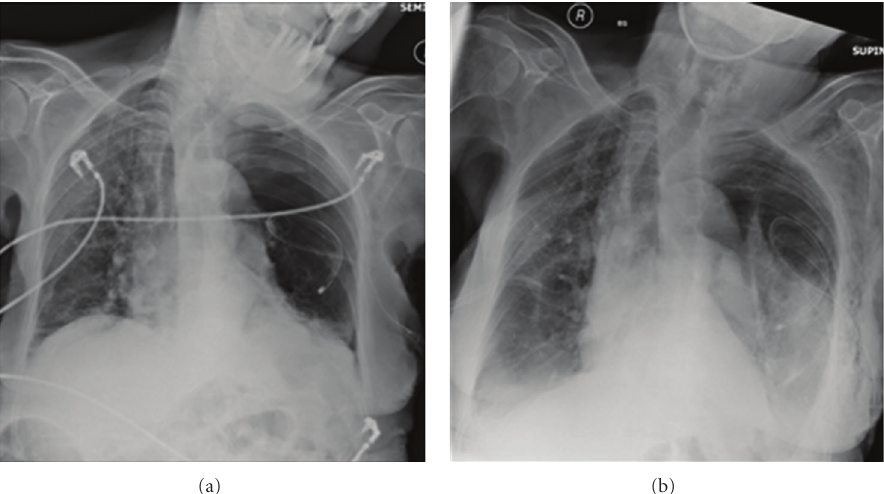
Figure 24: Two consecutive radiographs on the same patient as in Figure 24 showing a chest drain in situ at the left lung base. The patient’s symptoms worsened following insertion of the chest drain. A repeat chest radiograph shows an accumulation of fluid at the left lung base.